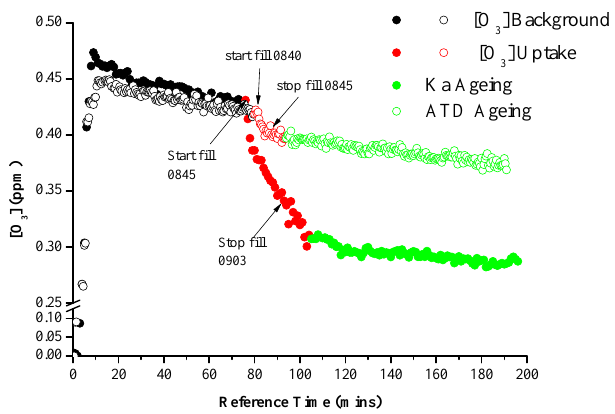
Fig. 4. Time series for O 3 ageing experiments in the aerosol tank. O 3 is added to the tank and a background wall-loss rate is observed. Arrows on the graph indicated start and stop times for filling dust. O 3 loss to the particle surface was considered to be first